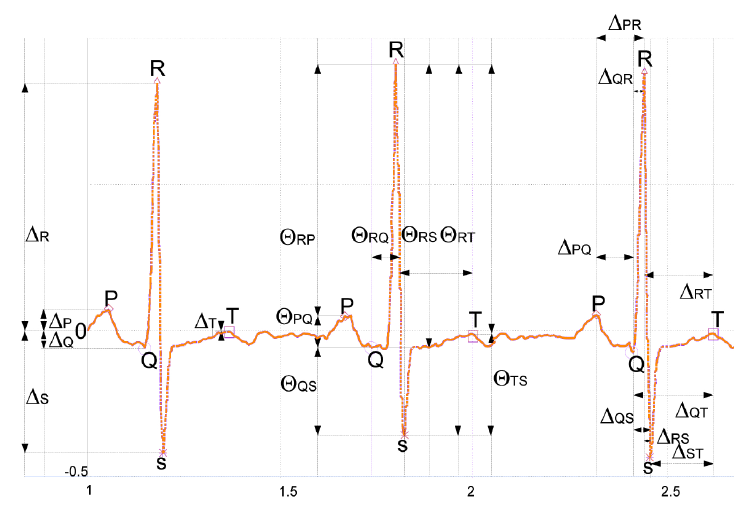
Figure 1. An ECG trace (three